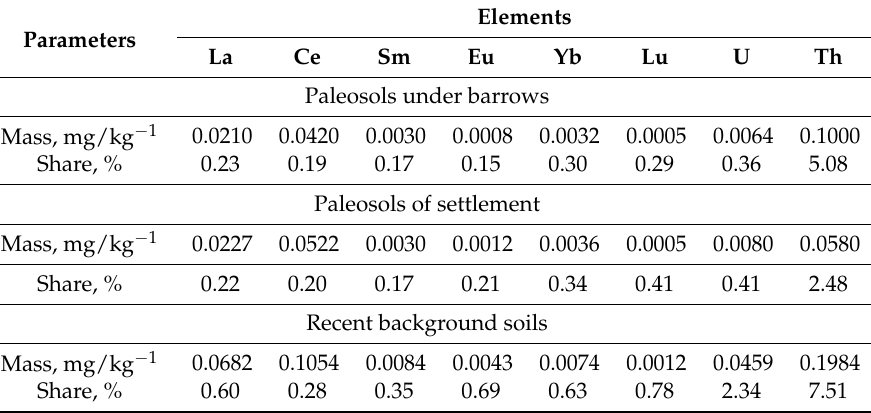
Table 4. The average content of some lanthanides and actinides in the humic acids recalculated to soil and paleosol carbon and HA contribution in their pool.